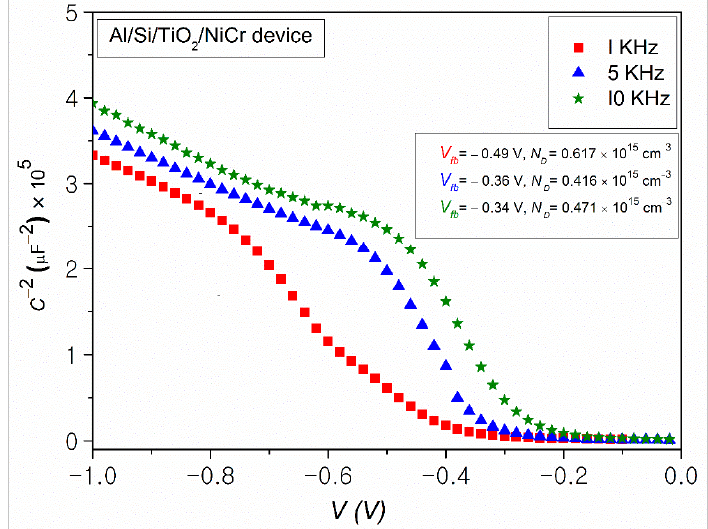
Figure 6. Mott–Schottky diagram for the Al / Si / TiO 2 / NiCr Schottky junction device at 1, 5, and 10 kHz. The values calculated for V fb and N D are shown in the inset.